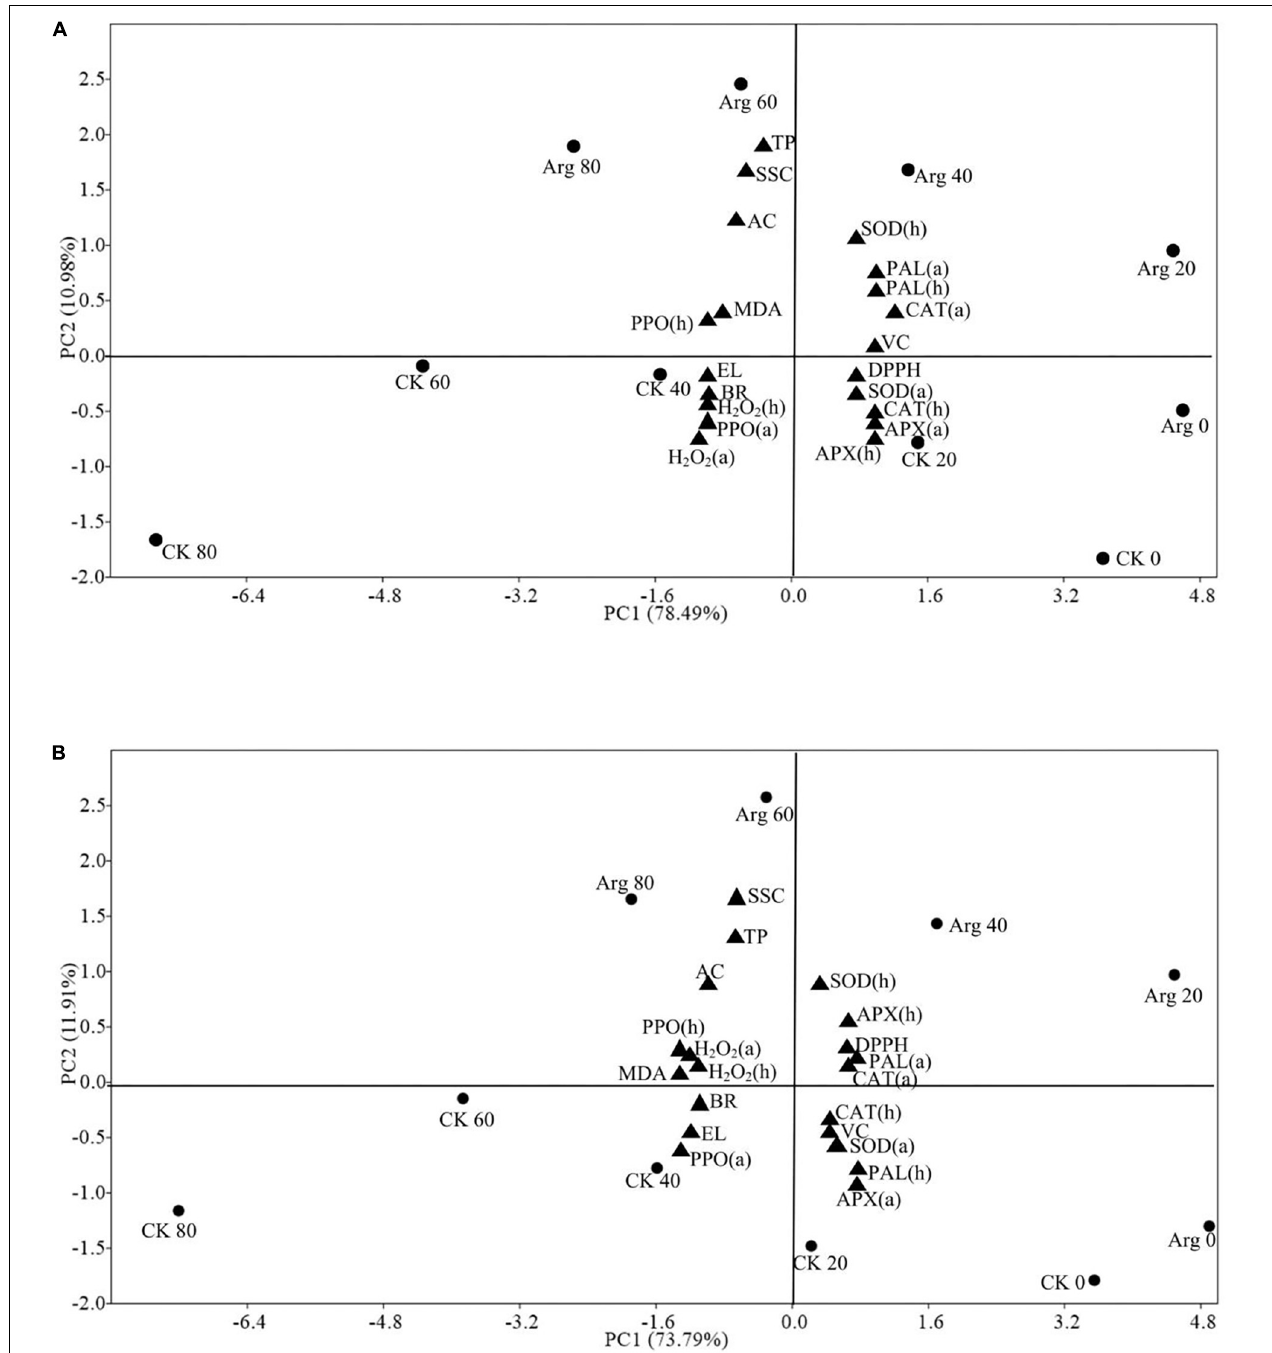
FIGURE 4 | PCA plot of fruit qualities and antioxidant activities in (A) Tunisia and (B) Yudazi pomegranate (a) arils and (h) husks treated with 1.0 mM Arg at 0, 20, 40, 60, and 80 days of the cold storage at 4 ± 0.5 ◦ C. BR, browning rate; EL, electrolyte leakage; AC, anthocyanin content; VC, vitamin C content; TP, total phenols content; Arg, arginine; CK, control